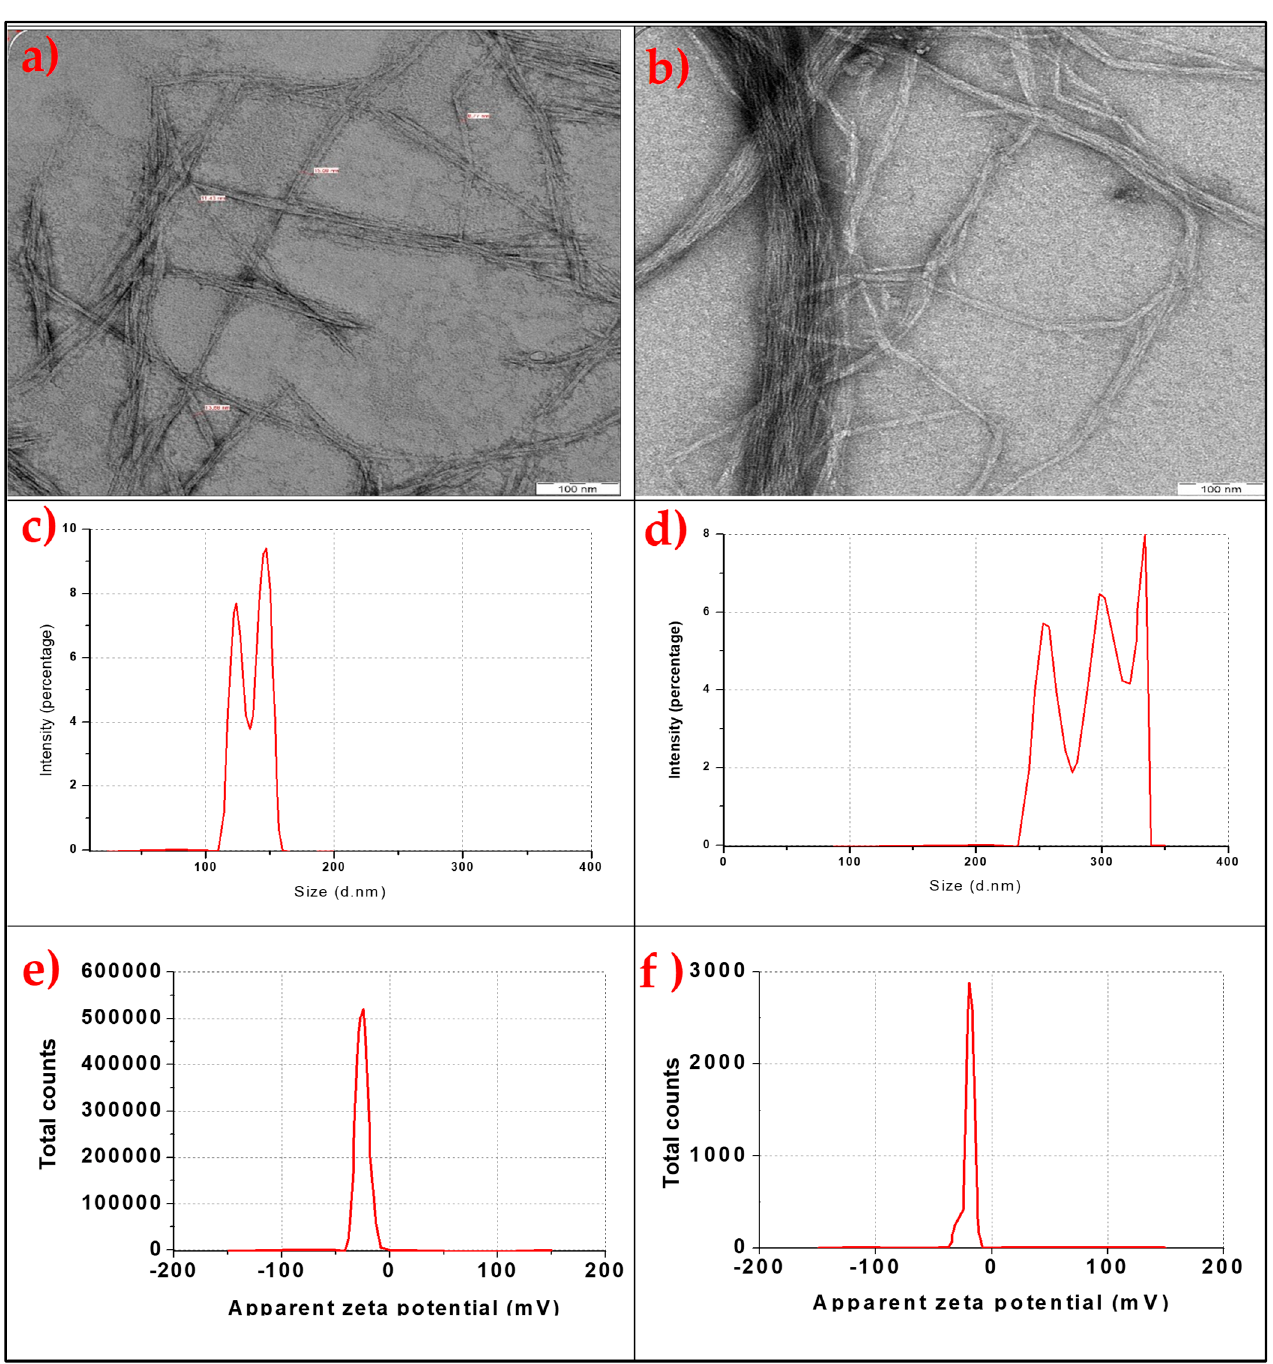
Figure 1. TEM images of ( a ) bamboo CNF; ( b ) commercial CNF, particle size analysis; ( c ) bamboo CNF; ( d ) commercial CNF, zeta potential analysis of ( e ) bamboo CNF; and ( f ) commercial CNF.